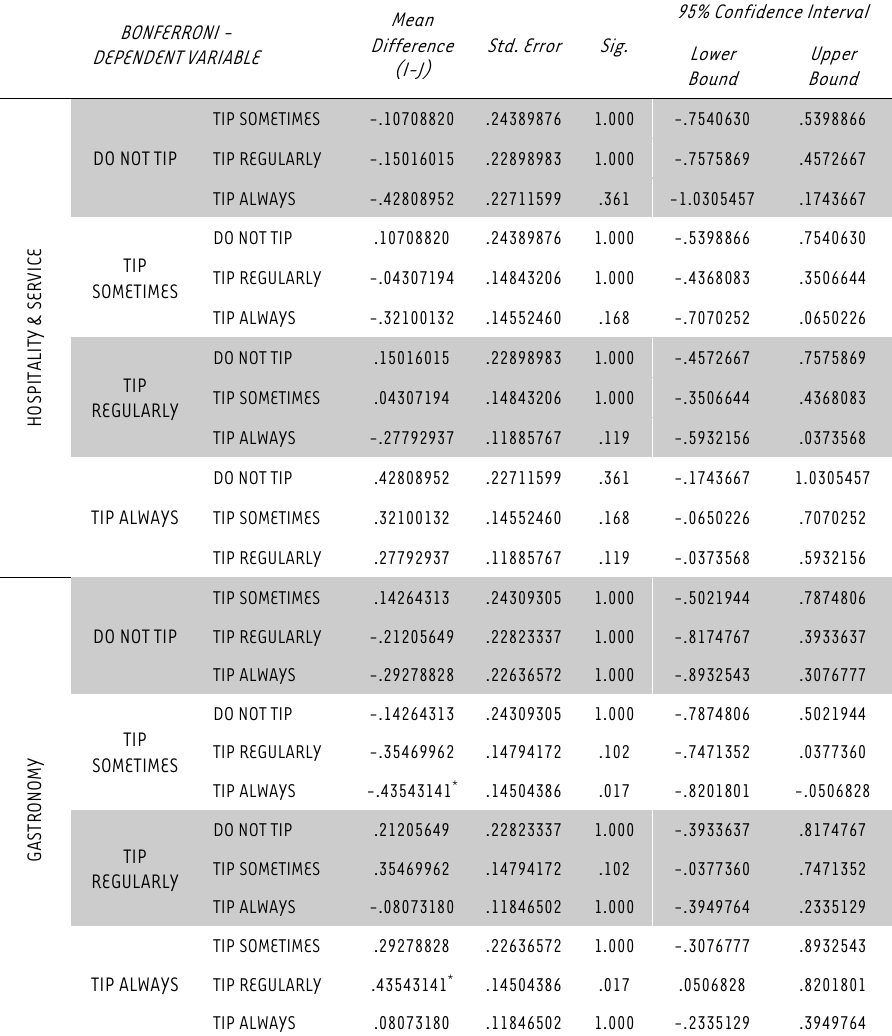
TABLE 4: Bonferroni corrections